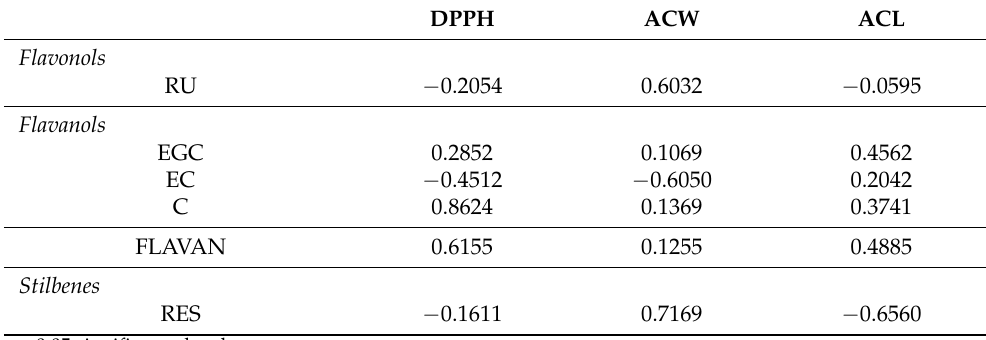
Table 11. Correlation coefficients (R) between different methods for AOA detection (DPPH, ACW and ACL) and individual flavonols (RU), individual flavanols (EGC, EC and C), total flavanols (FLAVAN) and resveratrol (RES) in the samples of the selected Sorbus cultivars. DPPH ACW ACL Flavonols RU − 0.2054 0.6032 − 0.0595 Flavanols EGC 0.2852 0.1069 0.4562 EC − 0.4512 − 0.6050 0.2042 0.8624 0.1369 0.3741 FLAVAN 0.6155 0.1255 0.4885 Stilbenes RES − 0.1611 0.7169 −